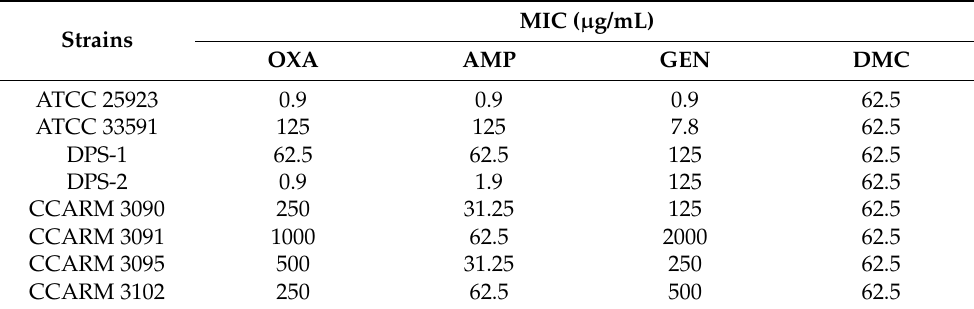
Table 1. Minimum inhibitory concentration (MIC) of oxacillin (OXA), ampicillin (AMP), gentamicin (GEN) and demethoxycurcumin (DMC) against eight S. aureus strains. MIC ( µ g/mL) Strains OXA AMP GEN DMC ATCC 25923 0.9 0.9 0.9 62.5 ATCC 33591 125 125 7.8 62.5 DPS-1 62.5 DPS-2 0.9 CCARM 3090 250 31.25 CCARM 3091 1000 62.5 2000 62.5 CCARM 3095 500 31.25 CCARM 3102 250